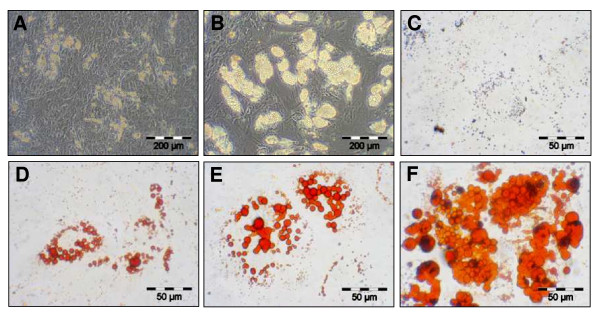
Adipogenic differentiation potential of human MSC (A-F). First the adipogenically induced human MSC lipid droplet formation became visible at day 5 (A). The number and size was continuously increasing until day 15 (B). Control cultures, even at day 15, showed no lipid droplet accumulation (C). Oil red O staining of lipid-droplets clearly confirmed adipogenesis at day 5 (D), 15 (E) and 20 (F).